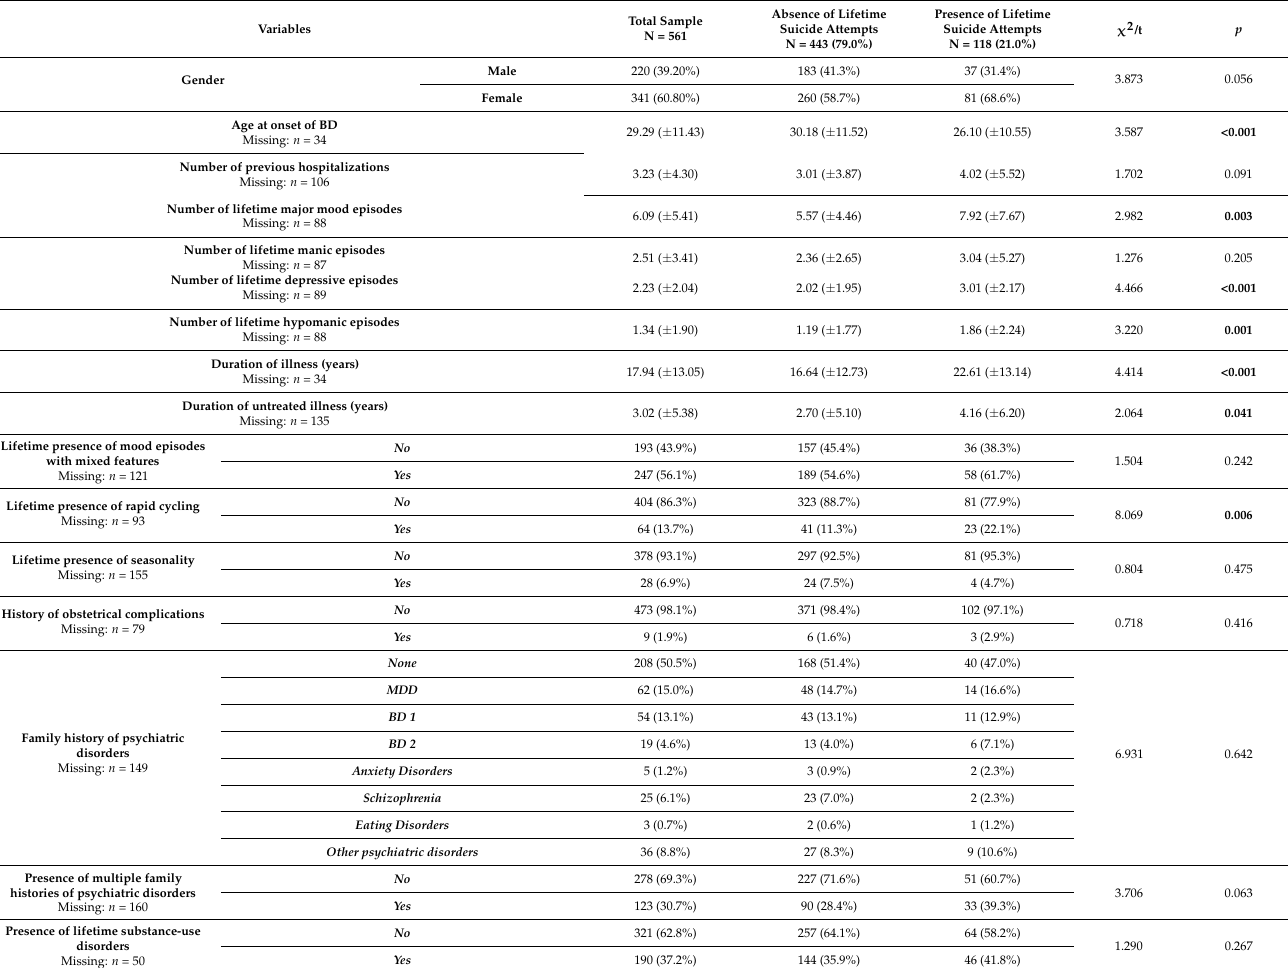
Table 1. Lifetime clinical variables of the total sample and the two groups obtained according to the presence of lifetime suicide